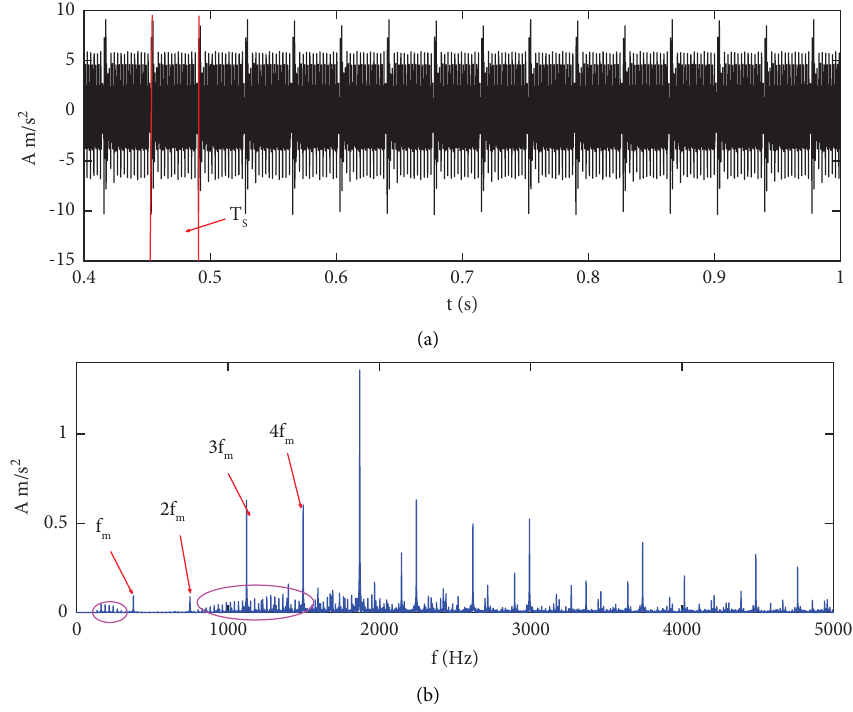
Figure 14: Responses of driven gear node: (a) the time domain; (b) the frequency